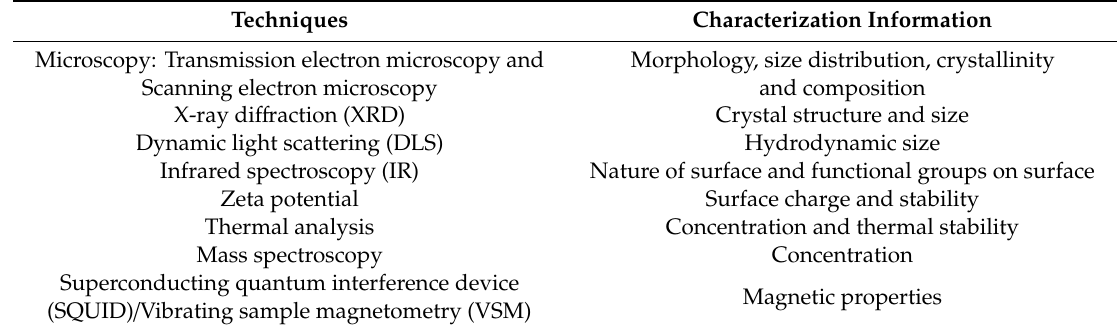
Table 1. Characterization techniques and their corresponding information obtained for magnetic nanoparticles